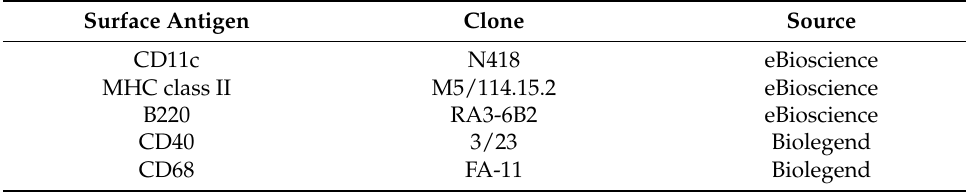
Table 1. Fluorescently conjugated antibodies for flow